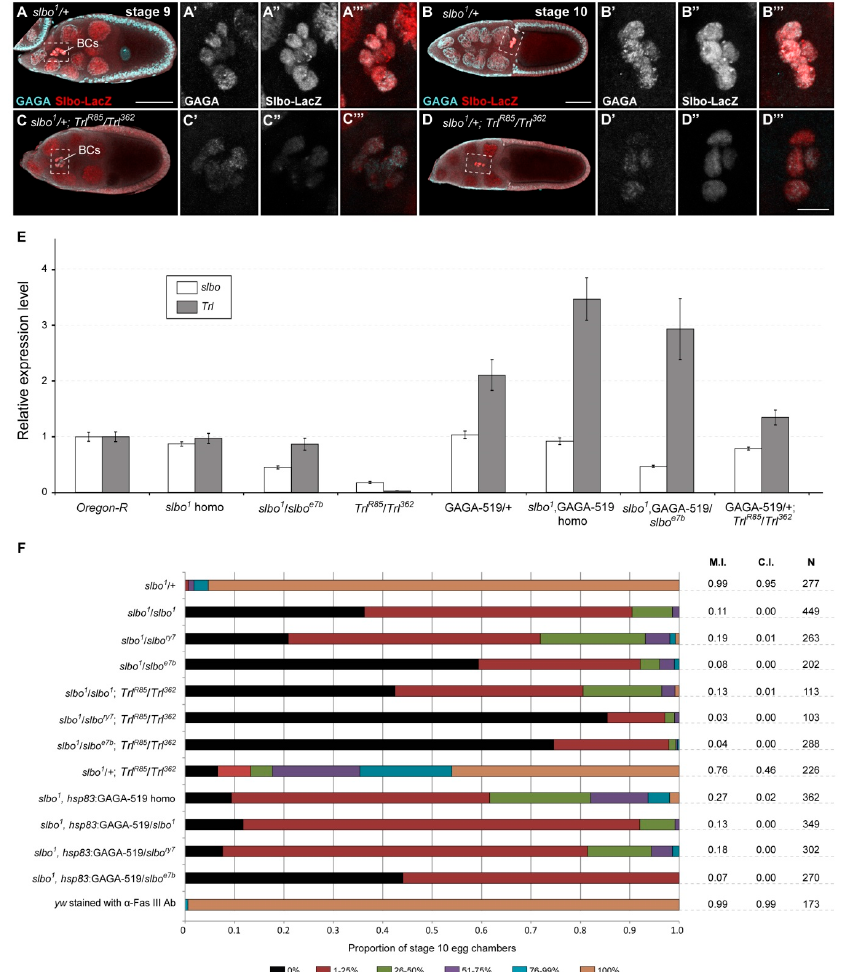
Figure 2. Downregulation of GAGA decreases the activity of the slow border cells ( slbo ) gene in migrating BCs. ( A – D ) Colocalization of β -galactosidase driven by the slbo-LacZ reporter ( slbo 1 enhancer trap mutation) and the GAGA protein in BCs. Anti-GAGA (cyan) and anti- β -galactosidase (red) immunostaining of slbo 1 /+ ( A , B ) and slbo 1 /+; Trl R85 / Trl 362 ( C , D ) egg chambers at stages 9 (A,C) and 10 (B,D). Note the reduction in GAGA and β -galactosidase signals in BCs of Trl mutants. The regions of BCs are marked by dotted frames and are enlarged in A’–A’’’, B’–B’’’, C’–C’’’ and D’–D’’’, in which single cyan (A’, B’, C’ and D’) and red (A’’, B’’, C’’ and D’’) channel images, as well as merge images (A’’’, B’’’, C’’’ and D’’’), are shown. All egg chambers were imaged at the same settings. Scale bar is 50 µm and 10 µm for A, C, B, D and the enlargements, respectively. ( E ) Comparison of the slbo and Trl mRNA levels (determined by RT-qPCR) in ovaries of the indicated genotypes. Error bars represent standard error of the mean. GAGA-519 denotes hsp83 :GAGA-519. ( F ) Downregulation of GAGA enhances BC migration defects observed in slbo mutants. “homo“ indicates homozygous state. Quantification of the BC migration phenotypes in stage 10 egg chambers of the indicated genotypes.